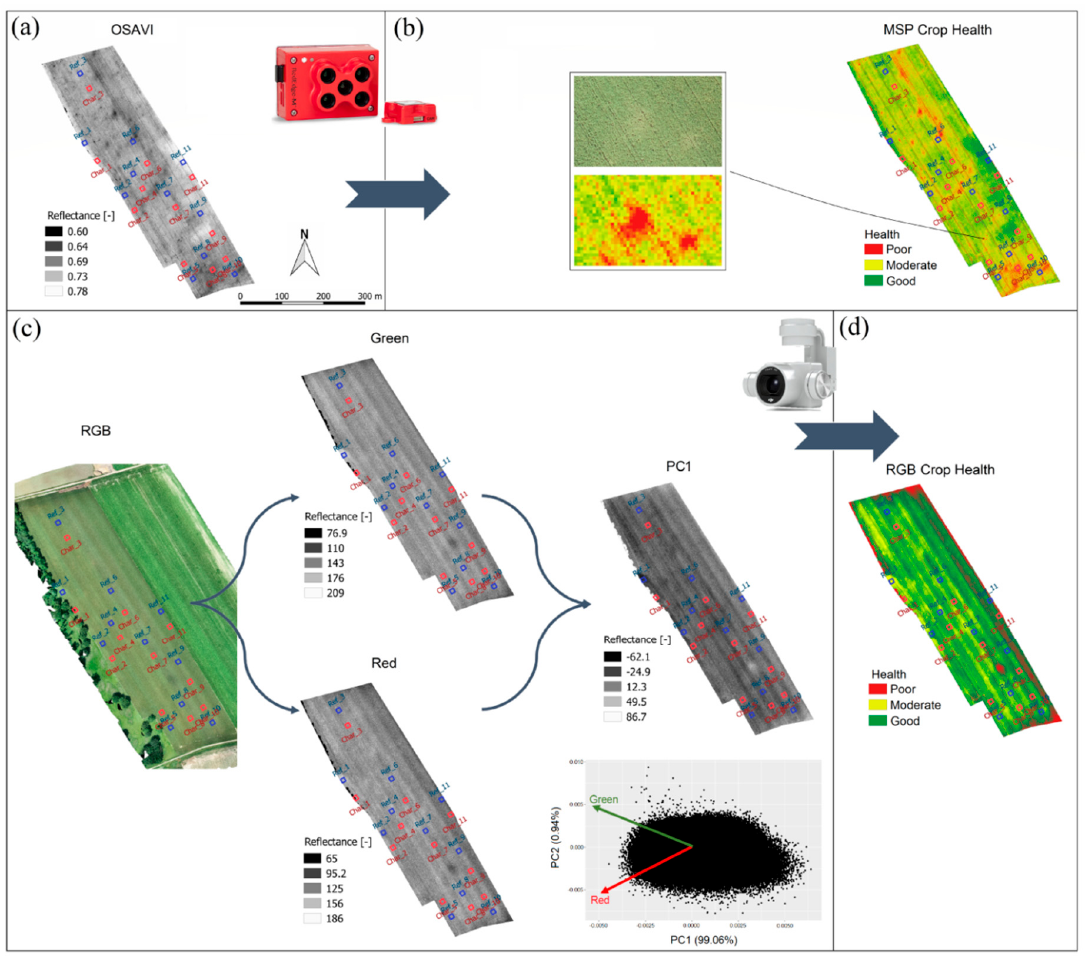
Figure 9. Data from 24 June 2019: ( a ) Map of optimized soil adjusted vegetation index (OSAVI). ( b ) Crop health map derived from the k-means clustering of OSAVI; the magnified window represents an example of an area characterized by poor crop health in the study field. ( c ) RGB orthomosaic image (left), the green and red spectral responses of the visible RGB orthomosaic image (middle), and the first component (PC1) raster of the principal component analysis (PCA) of the green and red bands (right). ( d ) Crop health map derived based on the k-means clustering of the PC1 raster of the PCA of green and red spectral channels.